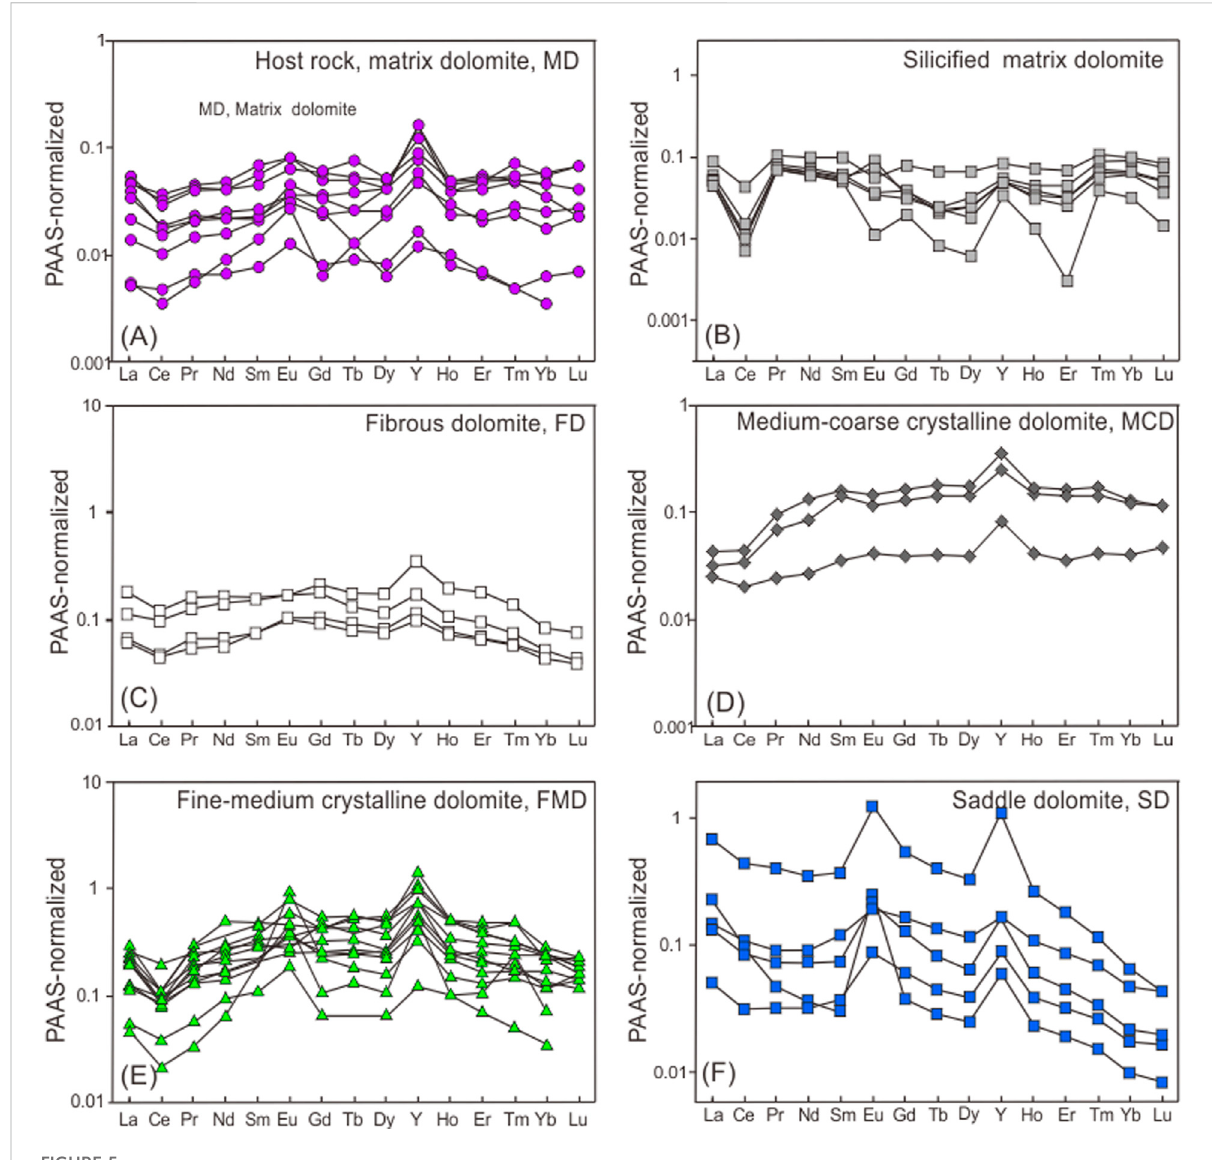
FIGURE 5 REE + Y distribution patterns for different rock fabrics in the Dengying Formation of Central Sichuan Basin (FD and SD data are from Su et al., 2022).